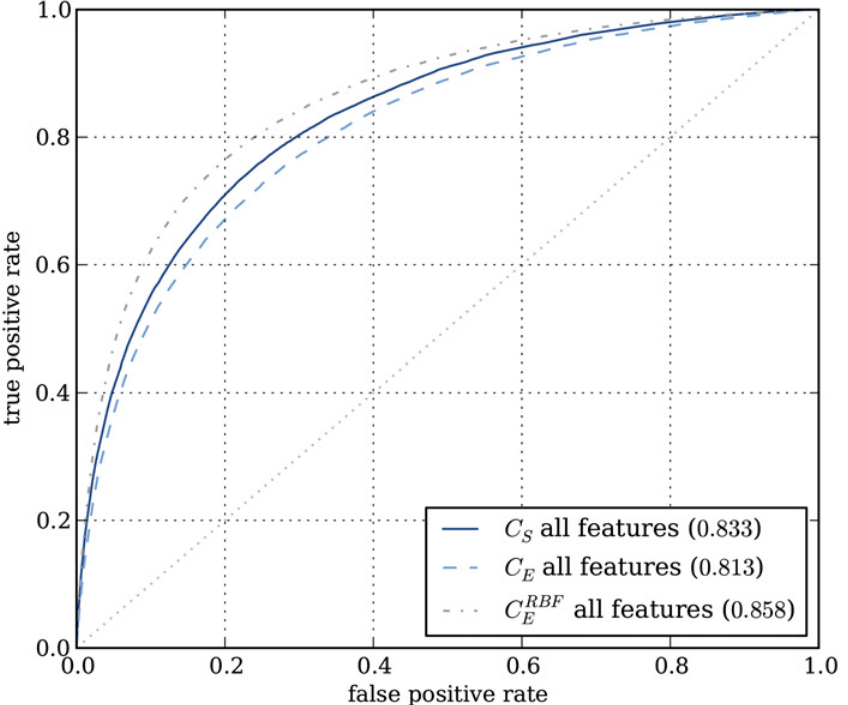
Fig 6. ROC-curves showing classifier performances using all features. In blue, performances for linear support machines using the combined subset classifier approach ( C S ), and for a classifier trained on the entire set of variants ( C E ). In gray the performance of a non-linear support vector machine (RBF kernel) trained on the entire set of